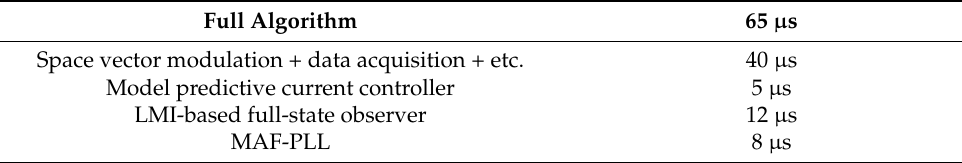
Table 2. Execution time of the proposed control scheme. Full Algorithm 65 µ s Space vector modulation + data acquisition + etc.